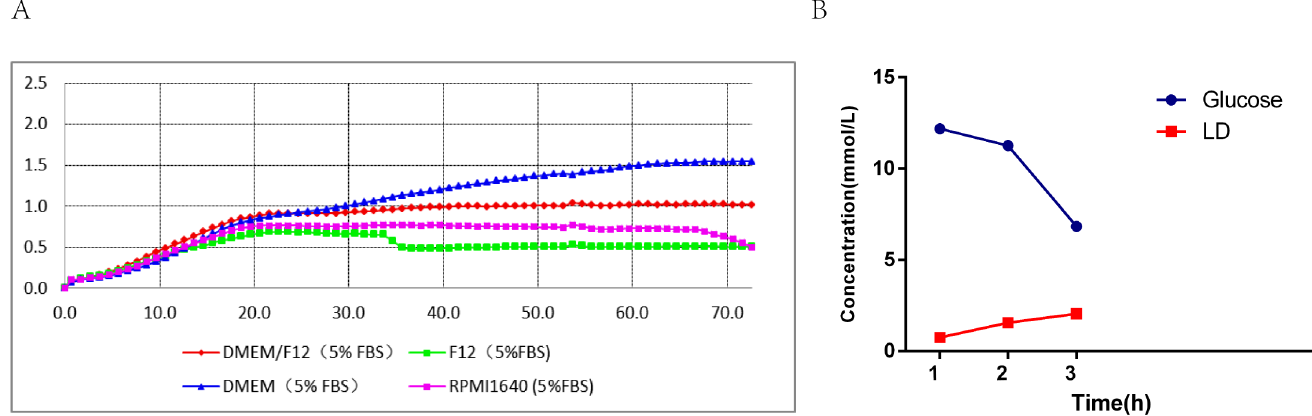
Fig 1. Basal medium screening. Four basic media were screened: DMDM (5%FBS), DMEM/F12 (5%FBS), F12 (5%FBS), RPMI1640(5%FBS).